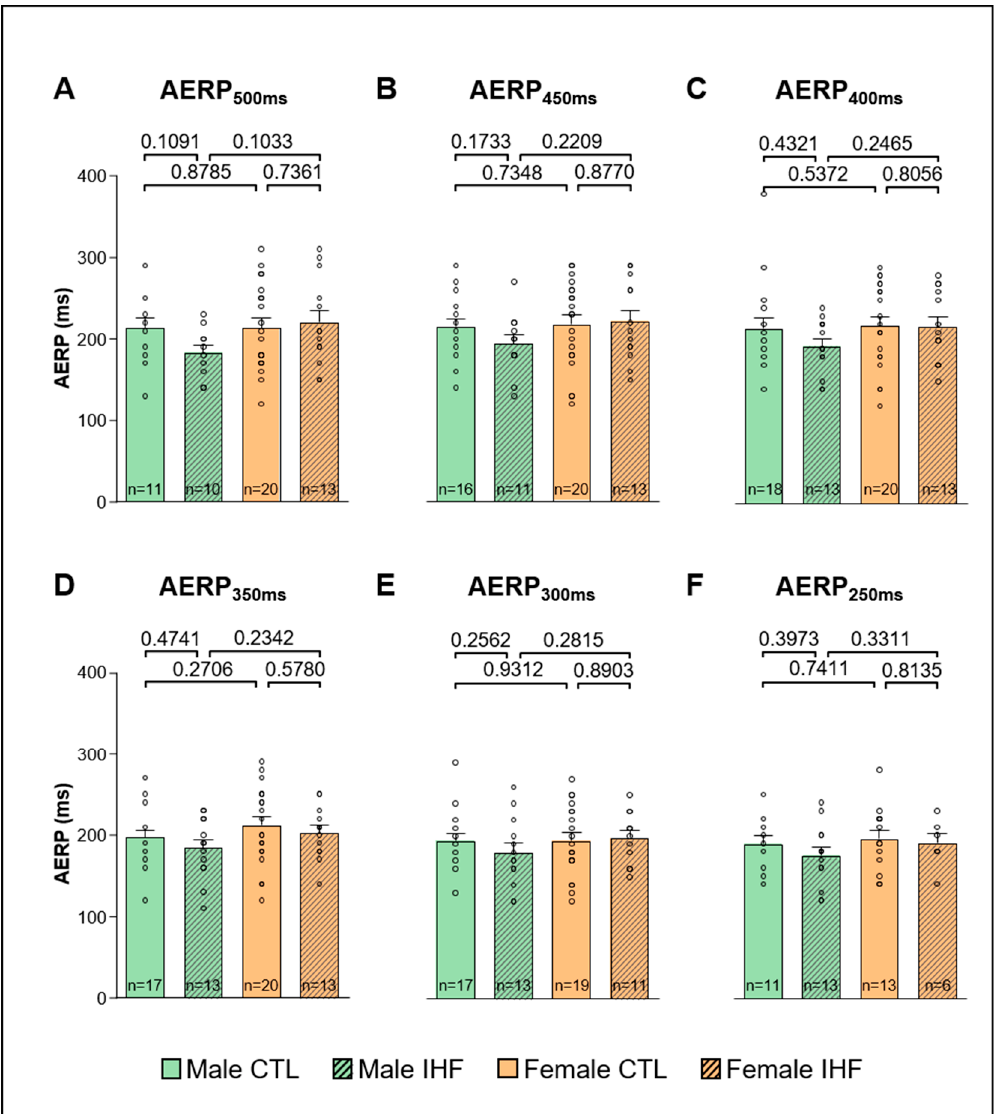
Figure 8. Atrial Effective Refractory Period (AERP). ( A ), AERP at a basic cycle length of 500 ms. ( B ), AERP at a basic cycle length of 450 ms. ( C ), AERP at a basic cycle length of 400 ms. ( D ), AERP at a basic cycle length of 350 ms. ( E ), AERP at a basic cycle length of 300 ms. ( F ), AERP at a basic cycle length of 250 ms. CTL , control animals without ischemic heart failure; IHF , animals with ischemic heart failure. Bar graphs represent Mean + SEM, grey circles represent data of individual pigs. Mann-Whitney-U